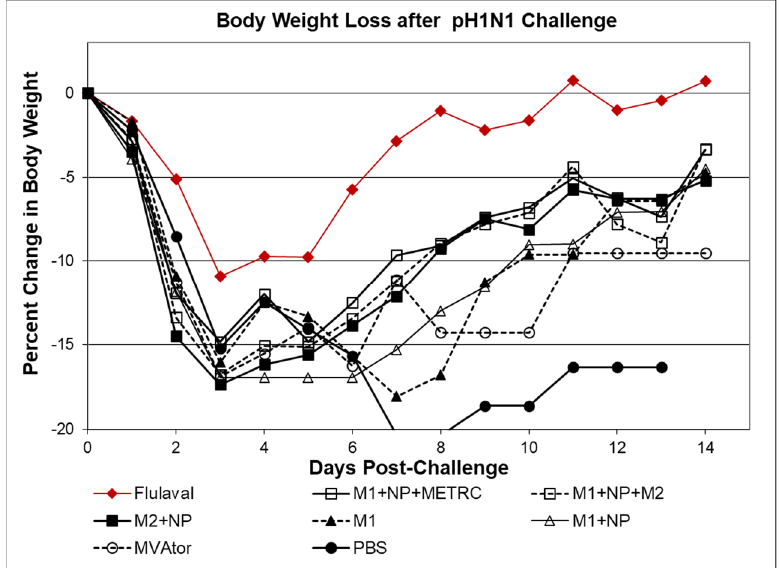
Figure 3. Change in body weight and survival of BALB/c mice challenged with six LD50 (LD99) pH1N1. Eight groups of mice ( N = 8) either immunized with various MVA-vector based vaccines or with MVA vector (MVAtor) were challenged with pH1N1 3 weeks after the final immunization. Daily body weights were monitored up to 14 days post-challenge. Weight loss >20% body weight was scored as death. Vaccines that delivered NP combined (blended) with M2 or METRC had similar (15%) weight loss that improved over the monitored period. Despite substantial weight loss in recipients of single antigen MVA-M1 vaccine, M1 did not lessen the benefit of blended MVA M1 + MVA NP + MVA M2 or blended MVA M1 + MVA NP + MVA METRC vaccines.